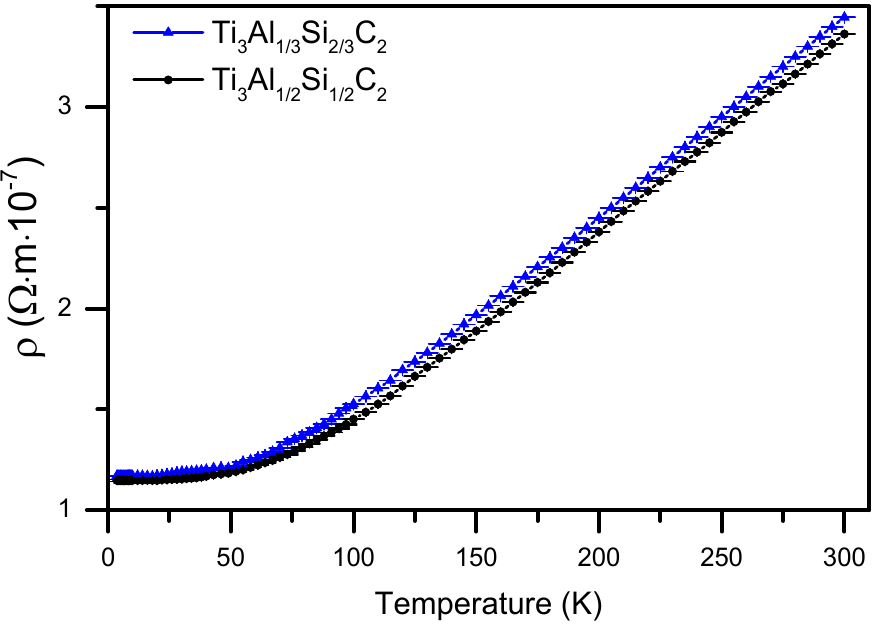
Figure 9. Electrical resistivity of Ti 3 (Al,Si)C 2 materials as a function of temperature. Experimental points with error bars are marked.